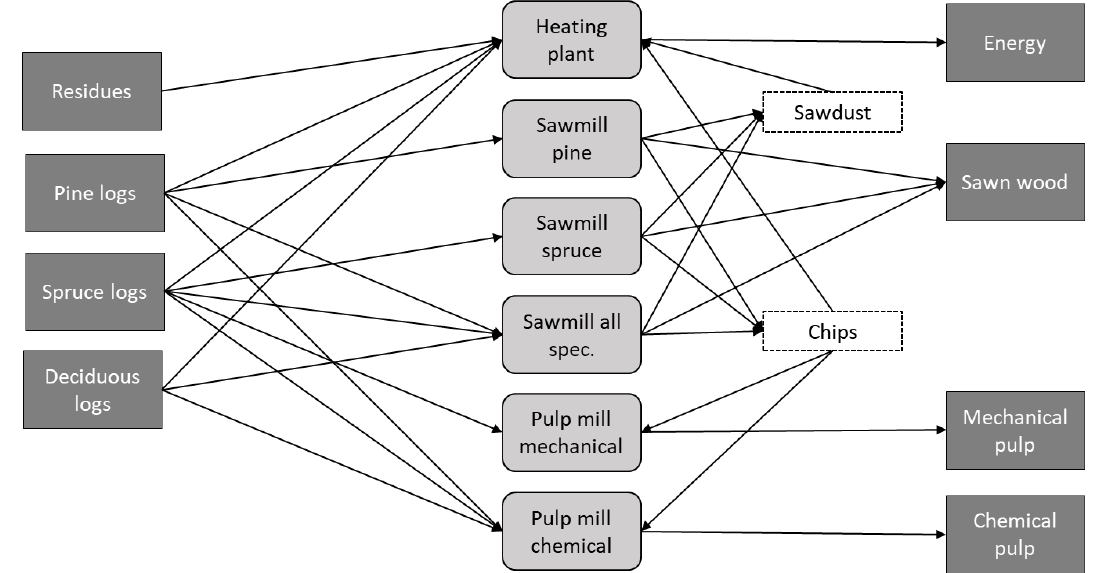
Figure 1. Types of biomass commodities that emanate from national forest inventory plots (boxes on the left), types of facilities that process feedstock (boxes in the center) thereby creating industrial by-products (i.e., sawdust and chips), and final marketed products (indicated on the right). In the mathematical description of SweFor sets and parameters are in capital letters, while indices and variables are in small letters (Table 1). Table 1. Notation used for describing the SweFor model.